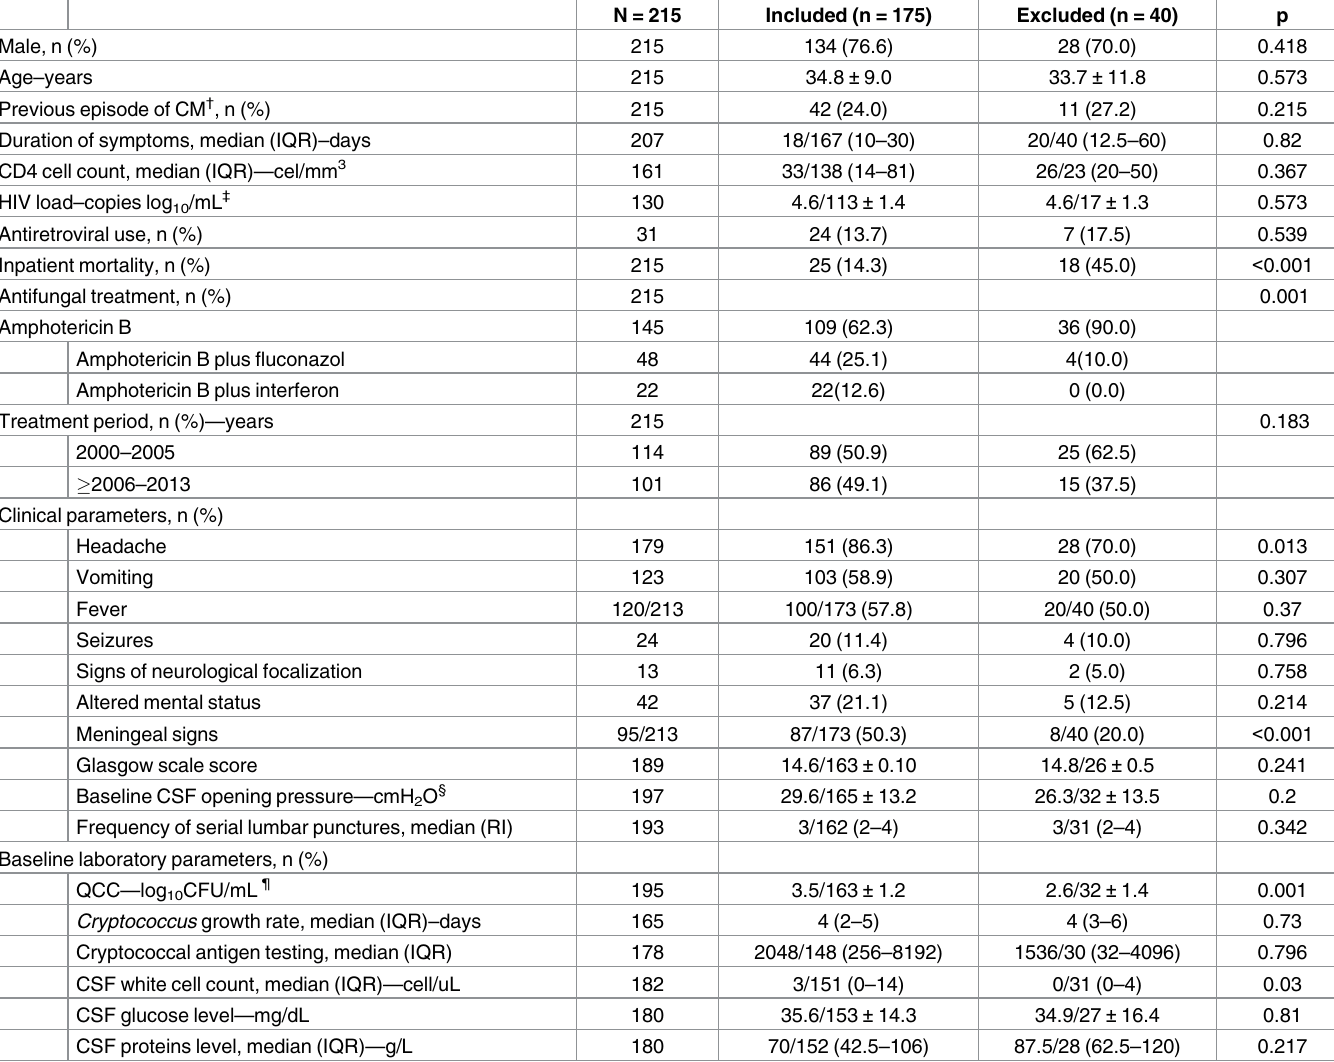
Table 1. Comparison of baseline clinical and laboratory characteristics between included and excluded cases with HIV-associated CM in Peru * . N =